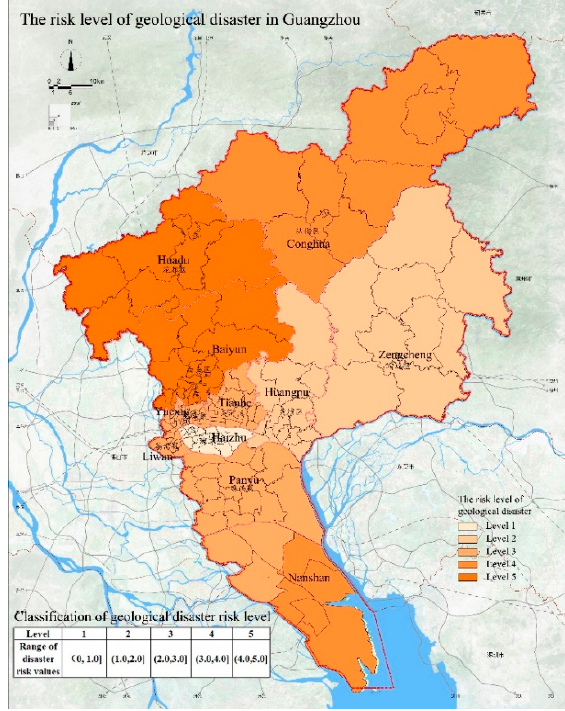
Figure 5. The risk levels of geological disaster in Guangzhou.